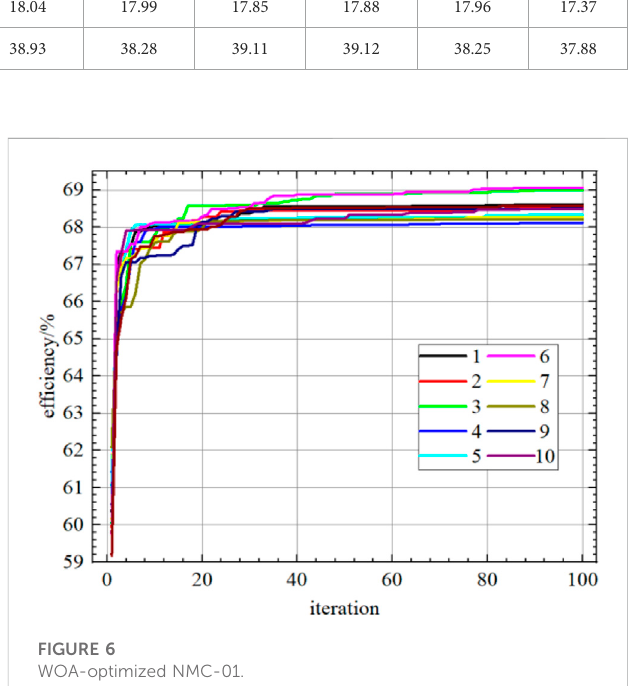
FIGURE 6 WOA-optimized